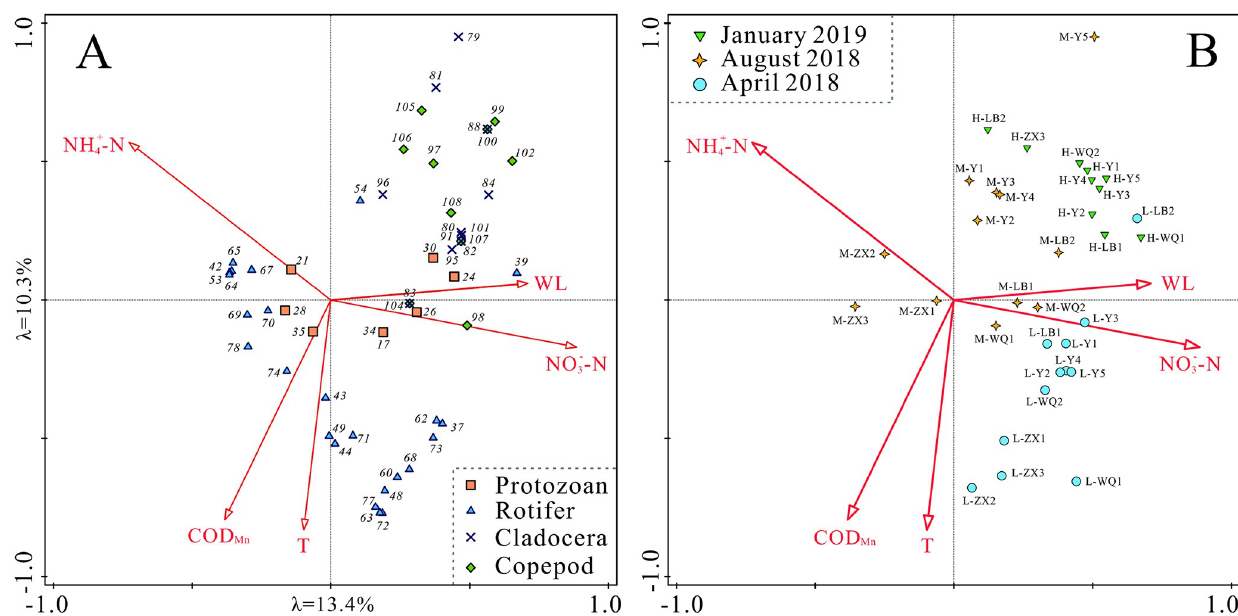
Fig 7. CCA ordination plot based on zooplankton biomass data and environmental factors. (A) zooplankton species vs. environmental factors, (B) samples vs. environmental factors. The number in (A) denoted for species, corresponding to that in S1 Table, the symbol in (B) expressed in form of “month-site”.